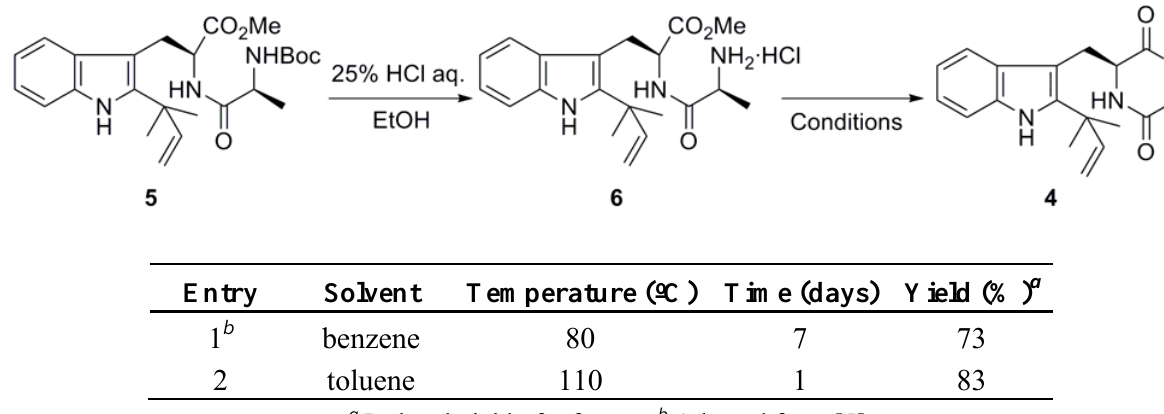
Table 2. Preparation of preechinulin ( 4